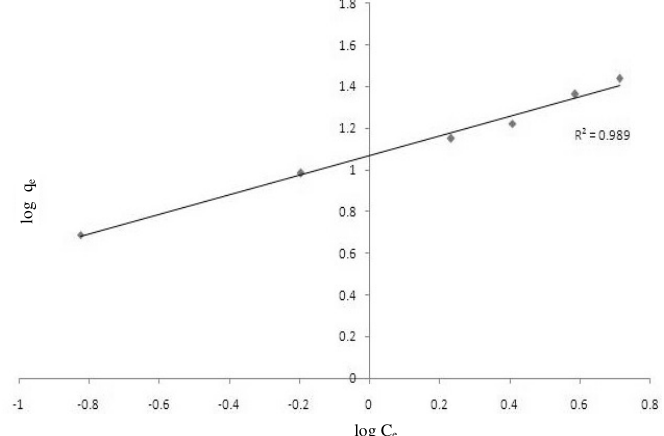
Figure 5. Freundlich adsorption isotherm of RHD dye onto